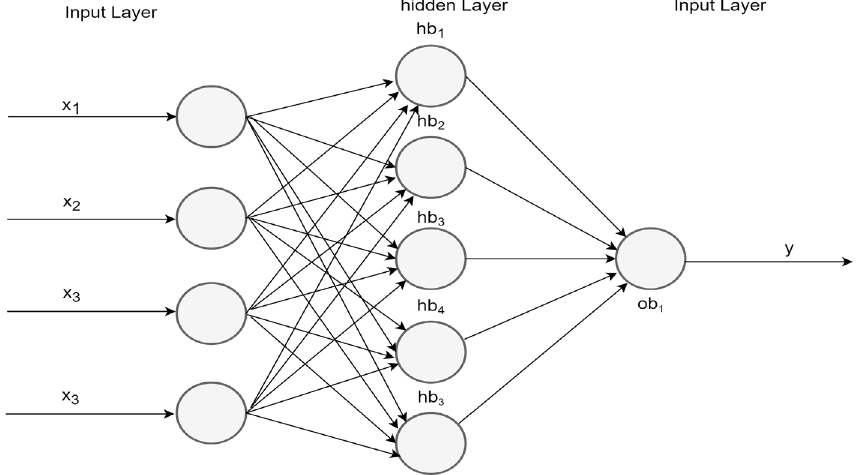
Fig. 5 Multi layer perception. Source :